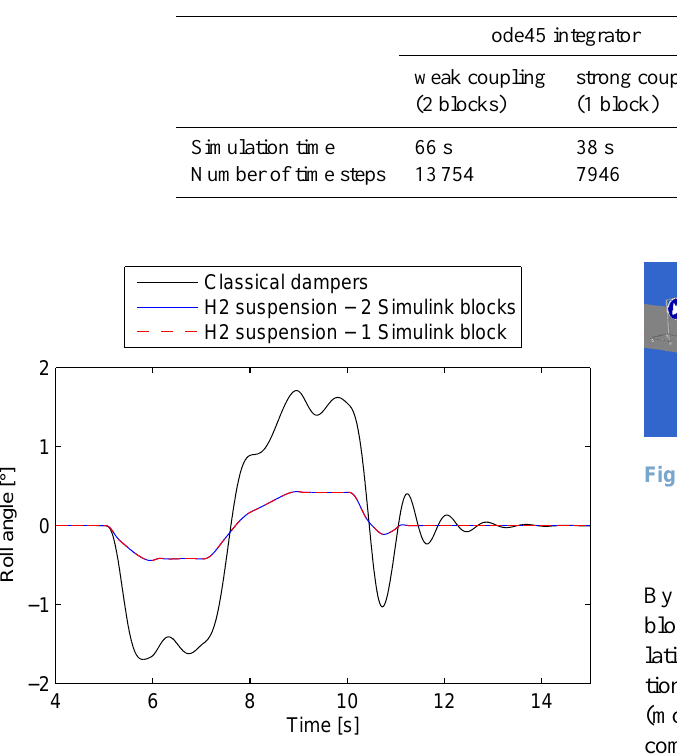
Figure 17. Impact of the Kinetic H2 suspension on the roll angle during the line change manoeuvre.